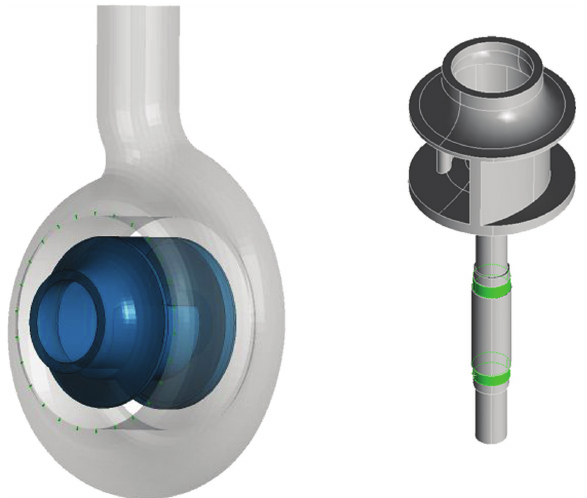
Figure 16: Flow calculation model and structural calculation